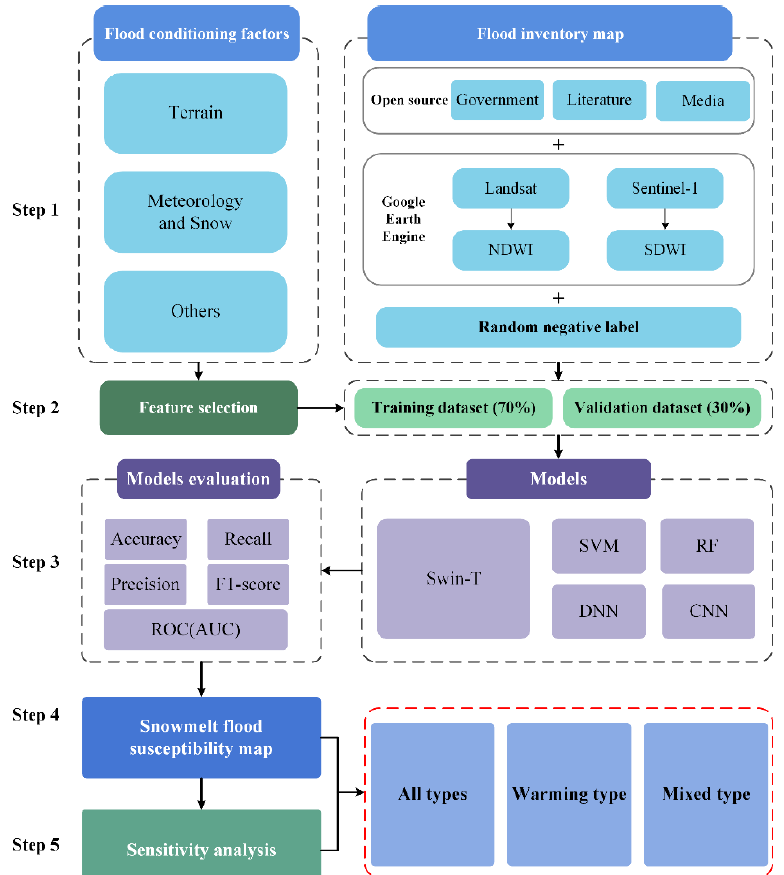
Figure 3. Flowchart of the proposed methodology.